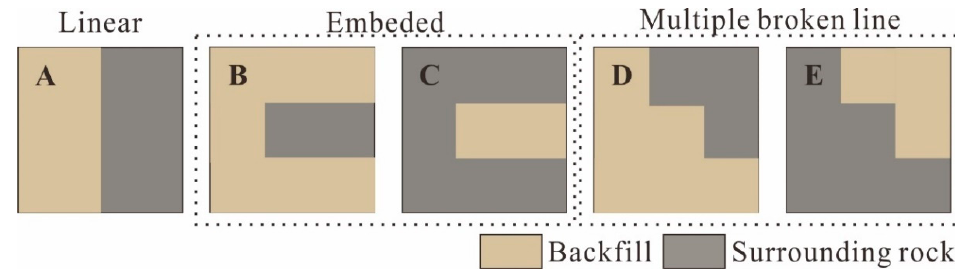
Figure 4. Classification of backfill-surrounding rock contact zones. ( A ) Linear model; ( B ) Embedded model with the filling body enclosed by surrounding rock; ( C ) Embedded model with the surrounding rock enclosed by filling body; ( D ) Multiple broken line model with the backfill located in the footwall; ( E ) Multiple broken line model with the surrounding rock located in the footwall.